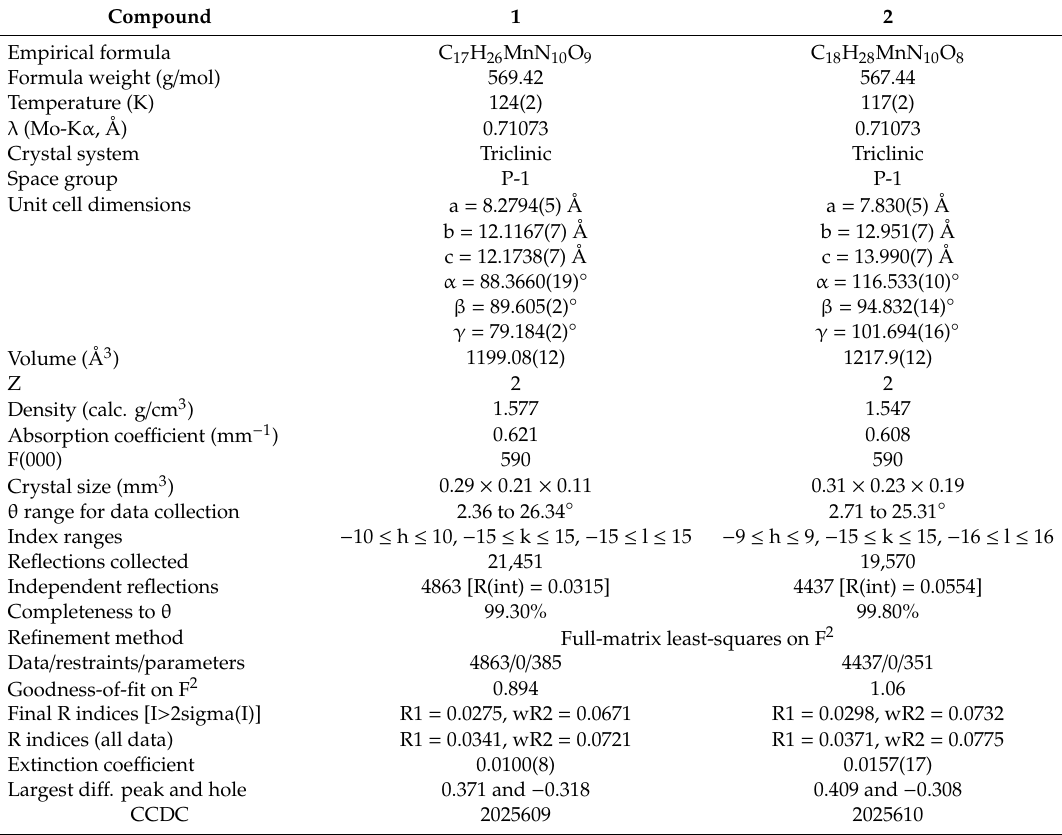
Table 1. Crystal and refinement data of 1 and 2